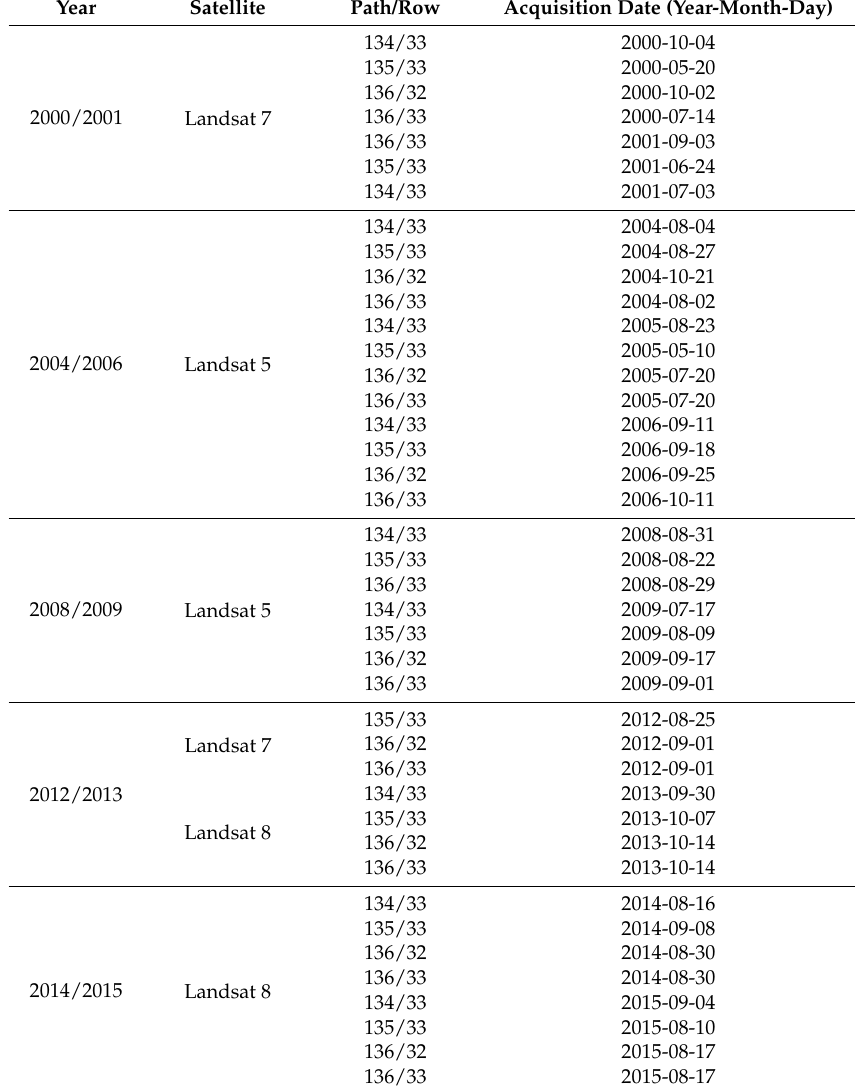
Table 1. List of remote sensing images of multiperiods for deriving glacier area changes in the Upper Reach of Shule River